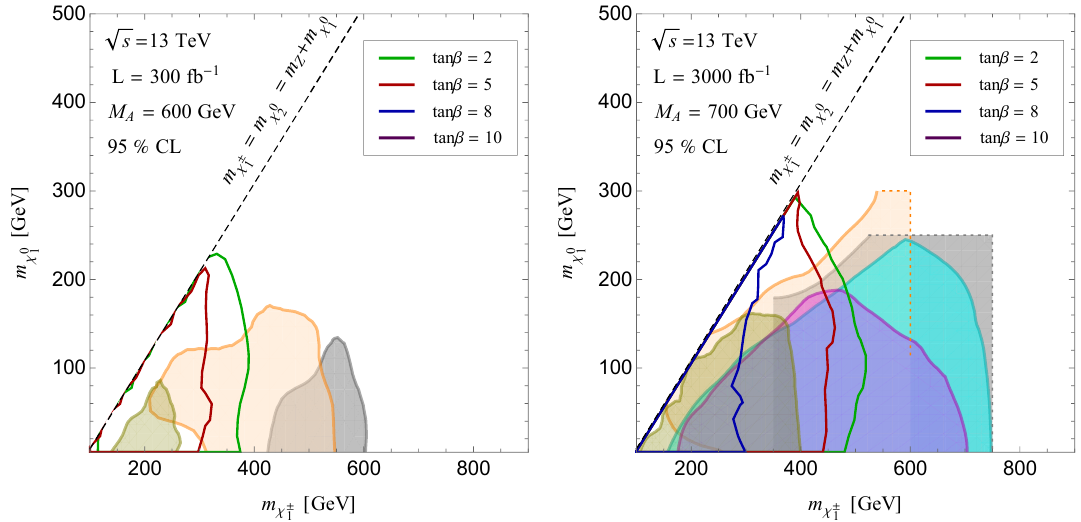
Figure 11 . Comparison between the H=A